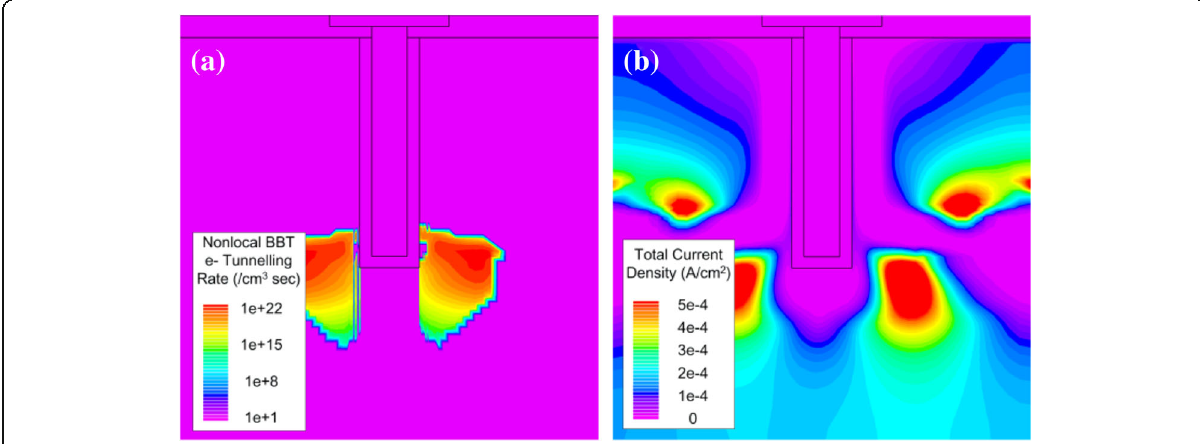
Fig. 8 Simulated diagrams of off-state a BTBT electron tunneling rate and b current density when Hc = 5